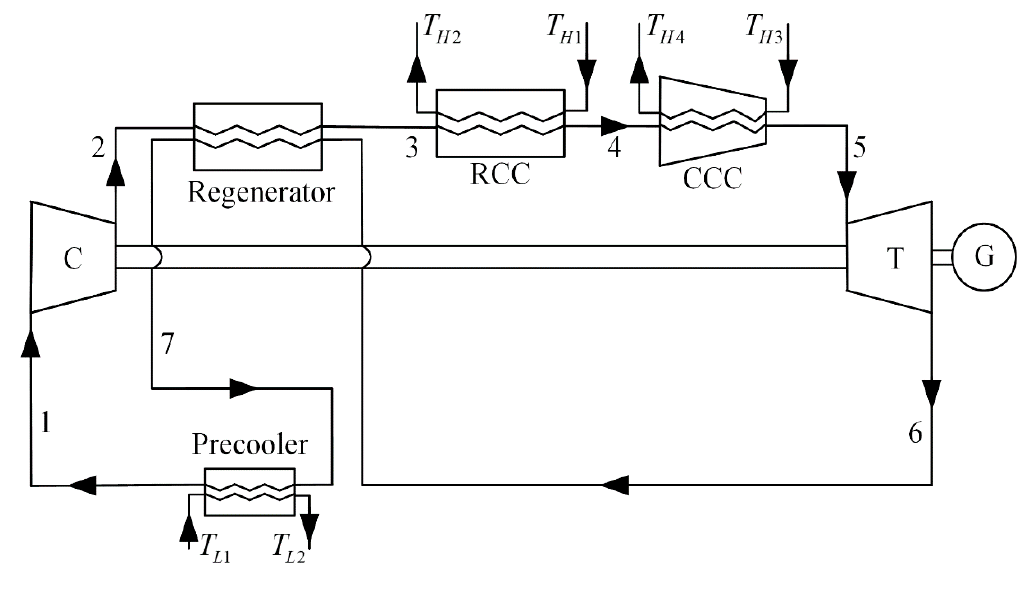
Figure 1. Schematic diagram of the cycle.